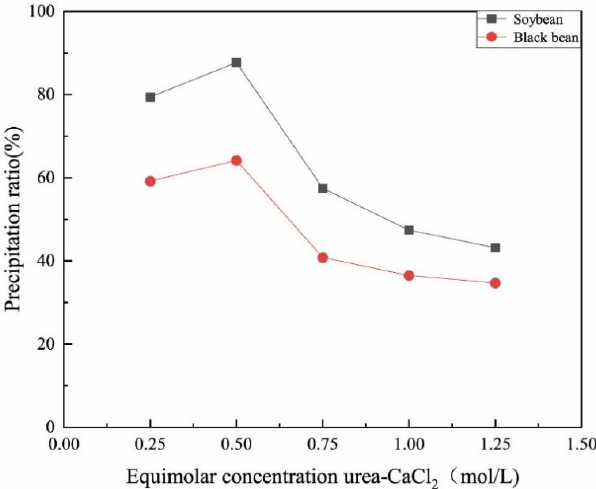
Figure 4. The relationship between the equimolar concentration urea–CaCl 2 and the precipitation